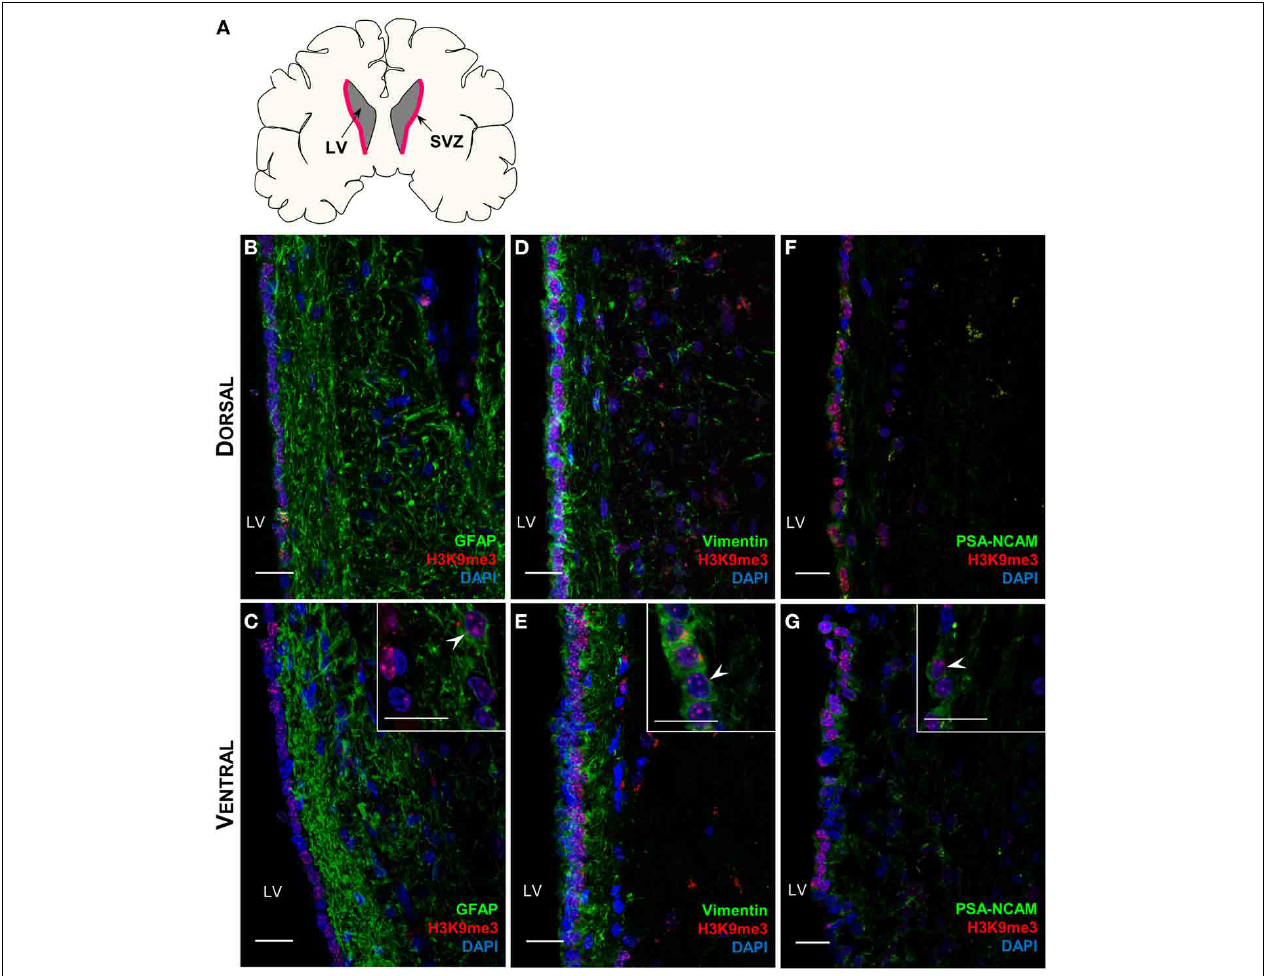
FIGURE 2 | Distribution of H3K9me3 in the neural progenitor populations of the baboon SVZ. (A) Coronal cross-section schematic of baboon forebrain, red highlighted area annotates SVZ. (B–G) Double labeling of H3K9me3 (red) and neural progenitor cell specific markers (green): (B,C) Only a small population of H3K9me3 positive cells co-localize with GFAP (NSC marker) in dorsal and ventral SVZ. (D,E) An